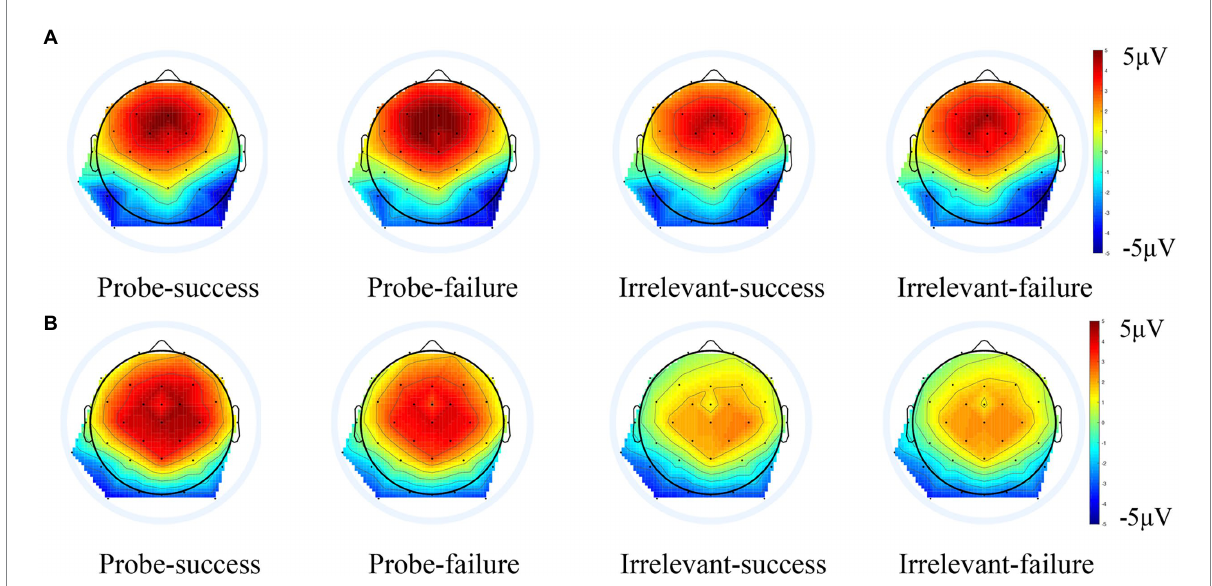
FIGURE 5 PCA-based Scalp distribution of the FRN (A) and feedback-P300 (B) during feedback stage combining guilty and innocent